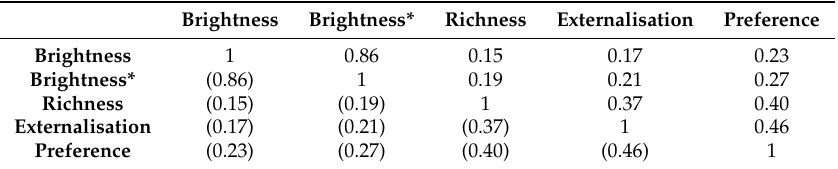
Table 6. Pearson’s correlation coefficient values calculated between attributes (excluding anchors and